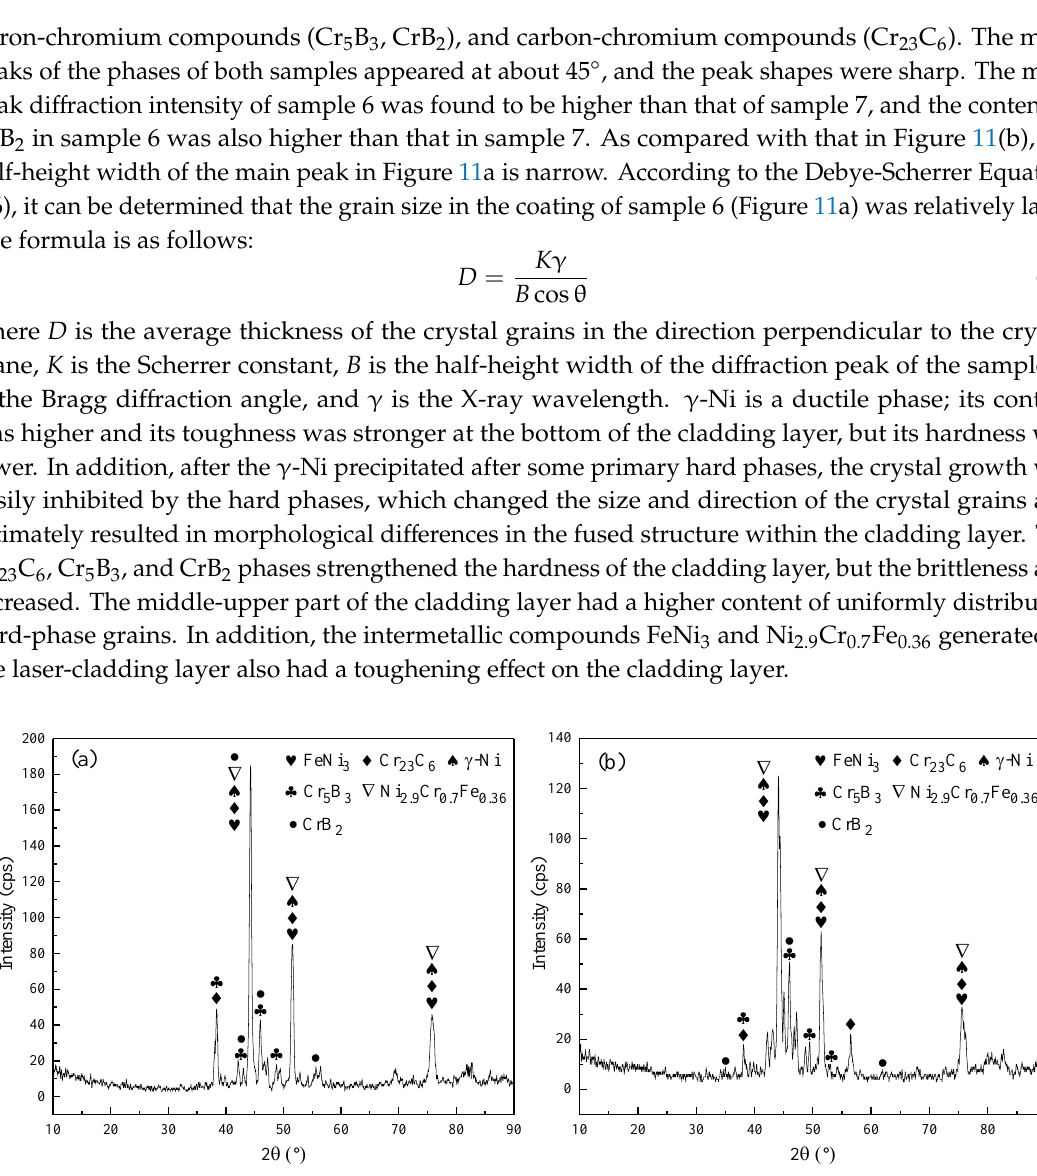
Figure 11. X-ray di ff raction pattern of the cladding layers of samples 6 and 7. ( a ) XDR pattern of the cladding layer of sample 6; ( b ) XDR pattern of the cladding layer of sample